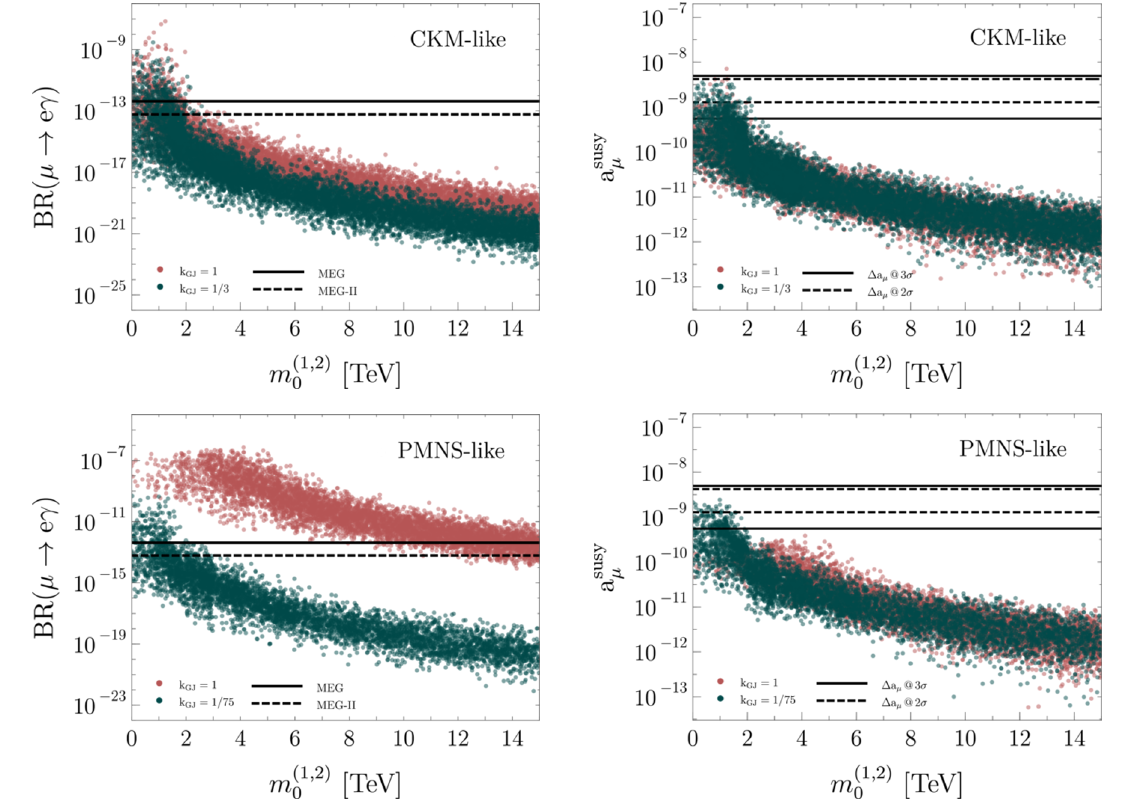
Figure 5 . Top: BR( (cid:22) ! e (cid:13) ) (left) and a susy (right) versus the common soft mass of the (cid:12)rst two (cid:22) generations of sleptons at the GUT scale in the CKM-like. Red/light points refer to k GJ = 1 while green/dark points correspond to k GJ 6 = 1. The black (dashed) lines signal the current (future) limit from MEG (MEG-II) [102, 103]. Bottom: the same as above but in the PMNS-like